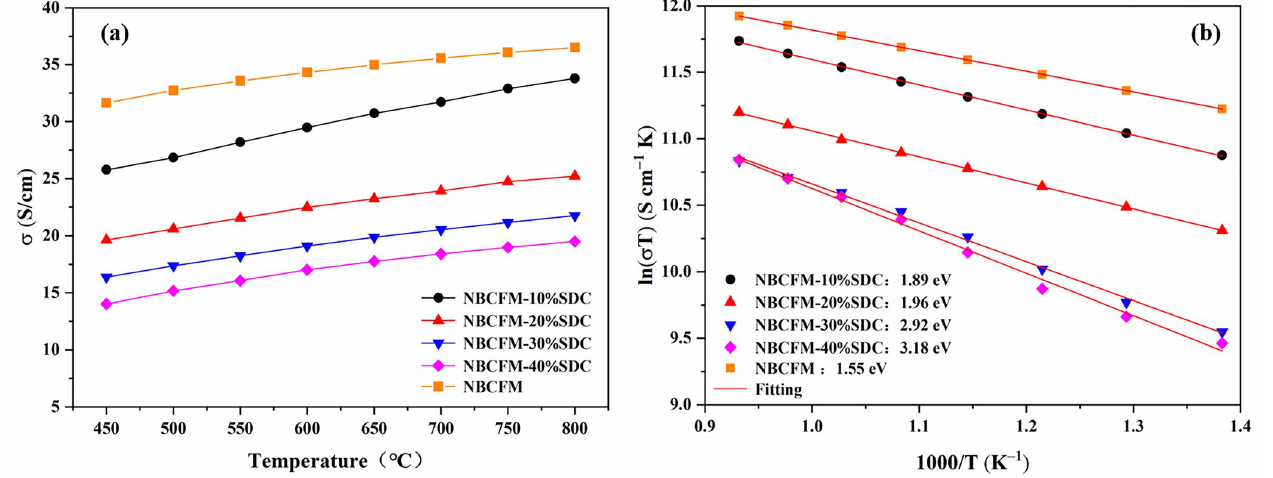
Figure 3. ( a ) Temperature dependence and ( b ) Arrhenius plots of the electrical conductivity for NBCFM and NBCFM- x